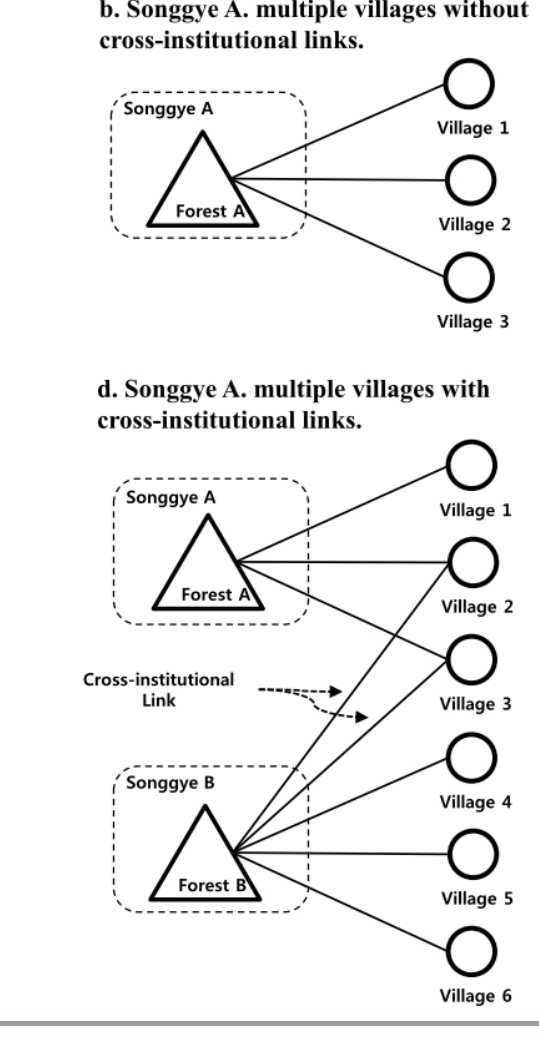
Fig. 3 . Types of village-to-songgye social connectedness. The link between a village and a forest represents a share in the property right of the forest and a participation in joint appropriation and provision activities. Triangles represent the biophysical boundary of the forest which is determined naturally by the physical boundary of a mountain along a contiguous range of mountains. The dashed rectangles indicate the institutional boundary of the